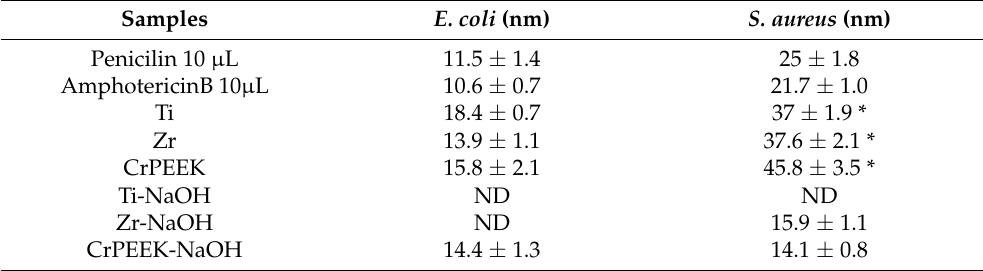
Table 1. Antibacterial effect of Ti, Zr, and CrPEEK samples against E. coli (nm) and S. aureus (nm) strains.